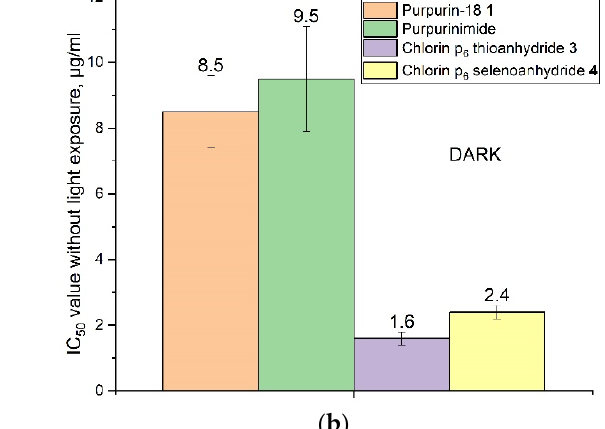
Figure 5. A study of photoinduced activity in vitro of tumor cells of mouse sarcoma S-37. The tested PS was added after 24 h at concentrations from 0.03 μ g/mL to 20 μ g/mL: ( a ) Photoinduced activity of compounds ( 1 ), ( 3 ), ( 4 ) and purpu- rinimide, with 4% micellar solutions of Kolliphor ELP. The time of incubation with photosensitizers before exposure to light was 4 h. The power density was 21.0 ± 1.0 mW/cm 2 and the calculated light dose was 10 J/cm 2 ; ( b ) Cytotoxic activity of compounds ( 1 ), ( 3 ), ( 4 ) and purpurinimide, with 4% micellar solutions of Kolliphor ELP.